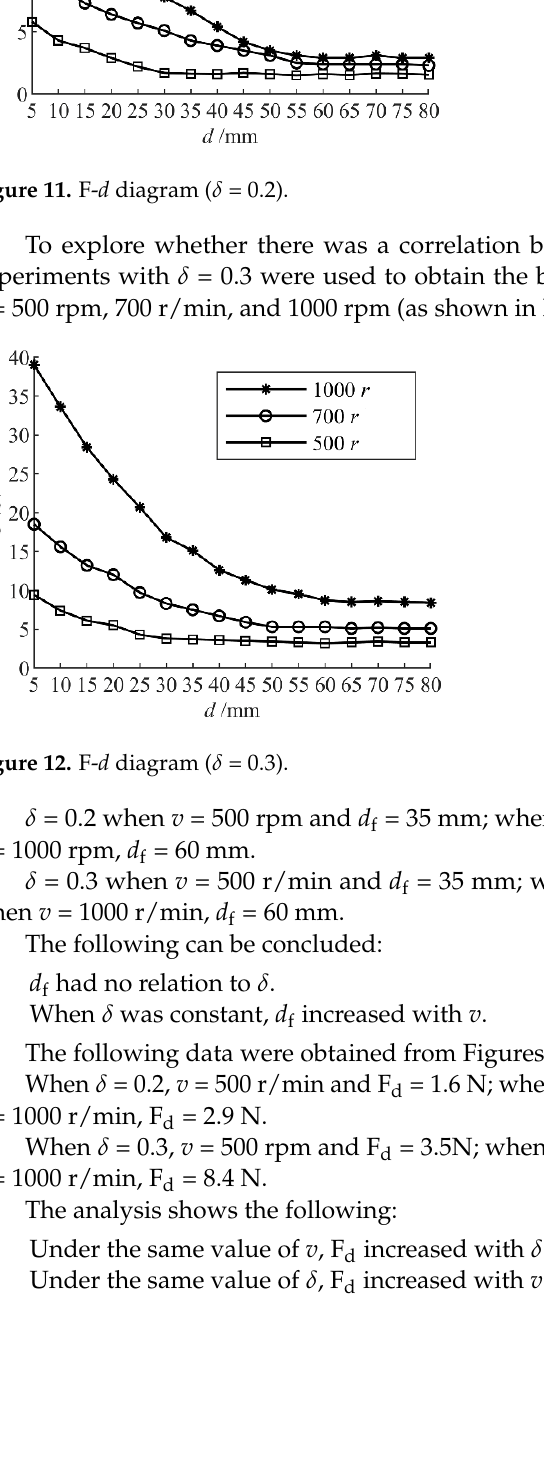
Figure 13. F- v diagram ( δ = 0.9, d = 5 mm).